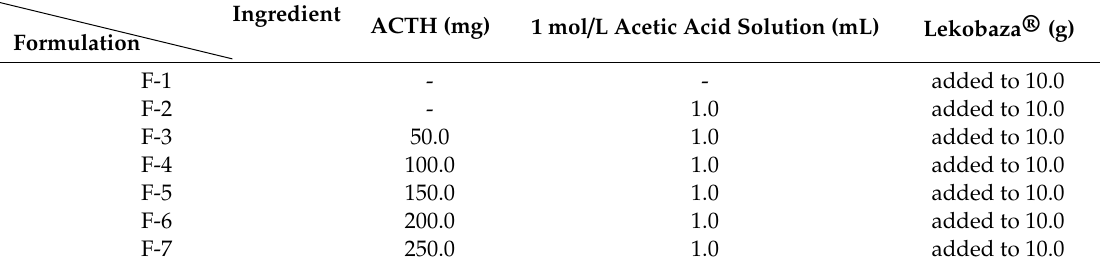
Table 7. Composition of the prepared ointment formulations for 10 g of